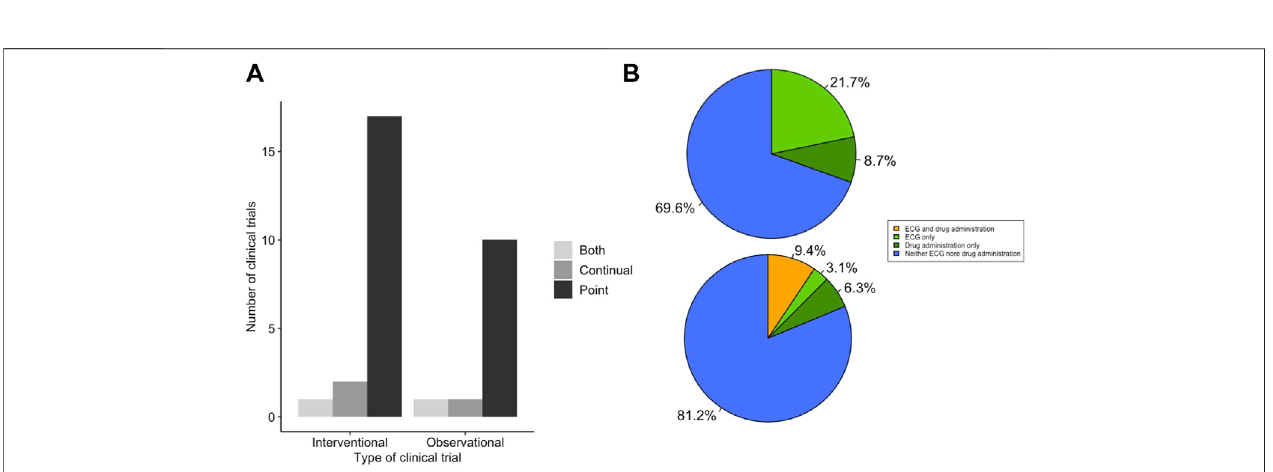
FIGURE 5 | QT-prolongation drug trials integrate drug and ECG timing to a low level. (A) Method of ECG recording for QT prolongation drug clinical trials. Trials werescoredforwhetheroutcomesreportedECGmeasurementsdeterminedbypointECGmeasurement(black),continualusingHoltermonitor(darkgrey)oroutcomes that used both point and continuous measurements (light grey). Interventional trials are classi fi ed as those involving some form of pharmaceutical challenge. (B) Integration of both drug and ECG timing in clinical trials for LQTS (top) or QT-prolonging drugs (bottom). Trials that take into account timing information are highlighted for: both ECG and drug delivery (orange), only ECG measurement/analysis (light green) and only drug administration (dark green).